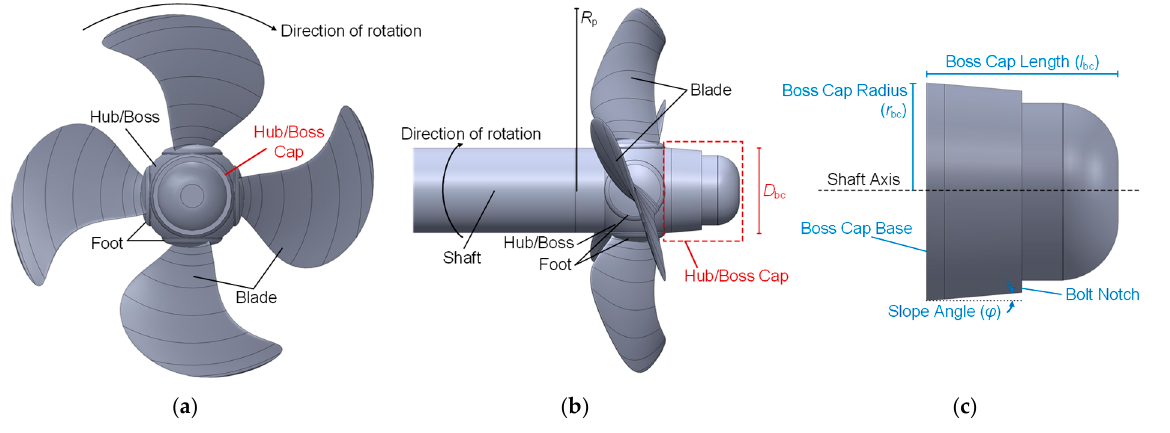
Figure 2. The model-scale propeller and propeller boss cap, in which R p represents the radius of the propeller, and D bc , r bc , l bc , and ϕ denote the diameter, radius, length, and slope angle of the boss cap, respectively. In this project, the slope angle ϕ < 0, i.e., a converging boss cap. ( a ) Frontal view of the propeller. ( b ) Side view of the propeller. ( c ) Side view of the boss cap. Table 2. The model-scale modern propeller investigated in this